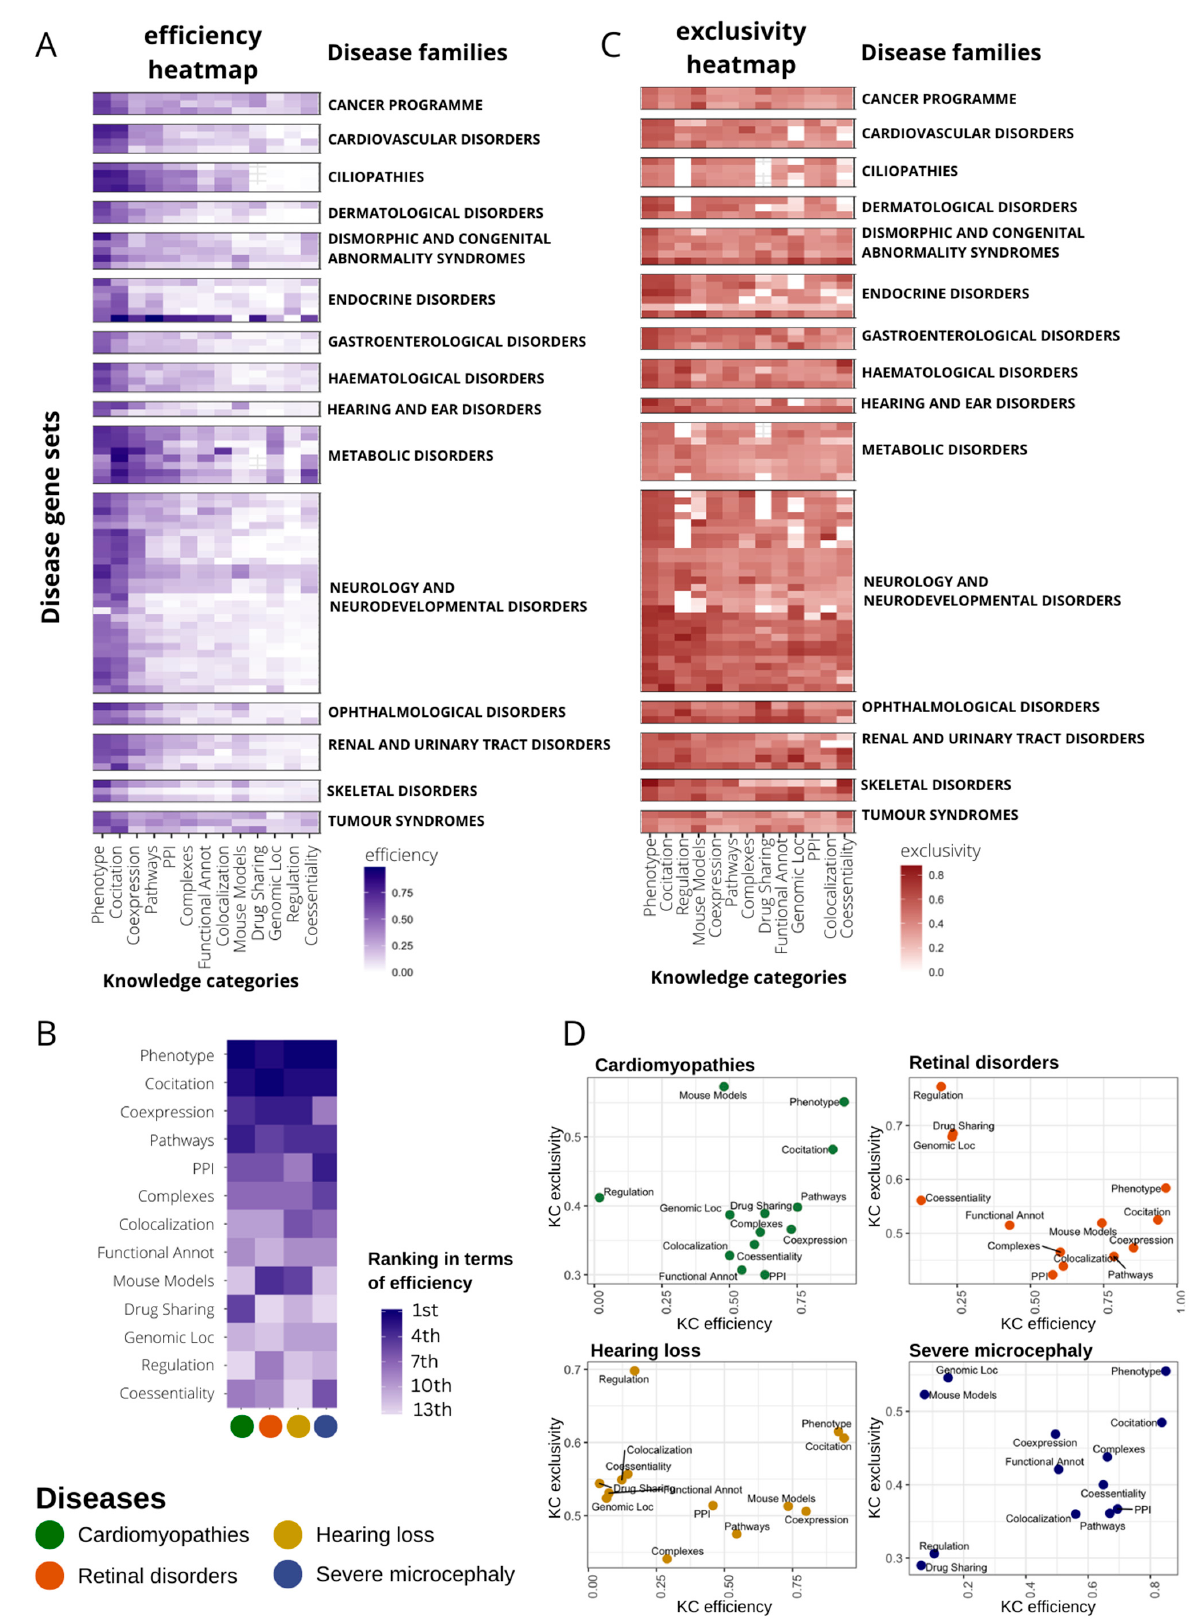
Figure 2. Disease-dependent performance of heterogeneous knowledge categories (KC) to recover gene–disease associations. ( A ) Heatmap representing the efficiency of every KC (x axis) in